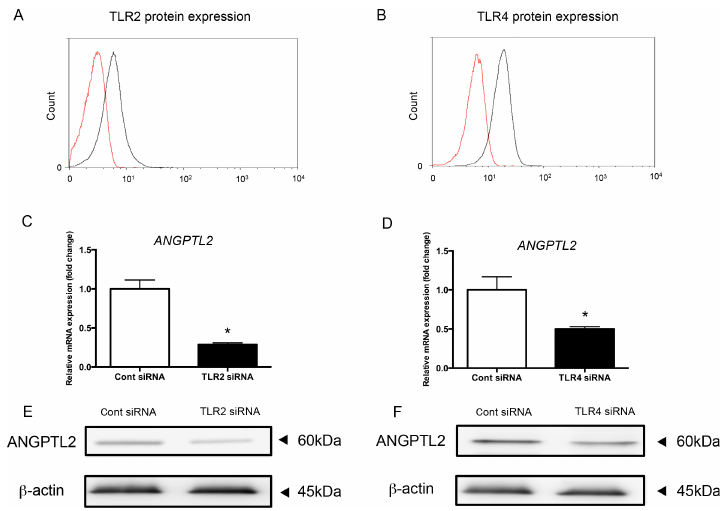
Fig 3. ANGPTL2 expression is suppressed by TLR2 or TLR4 siRNA in Ca9-22 cells. (A, B) TLR2 (A) and TLR4 (B) protein levels Ca9-22cells transfected with TLR2 and TLR4 siRNA (red line), respectively, and control siRNA-transfected cells (black line). (C, D) ANGPTL2 mRNA levels in Ca9-22 cells transfected with TLR2 and TLR4 siRNA after stimulationwith 30 ng/ml P . gingivalis LPS for 24 h. Differencesamonggroups were analyzedwith the Student’s t -test. Data are expressedas means ± SD ( n = 3). * p < 0.05 vs control. (E, F) Western blot analysisof ANGPTL2 protein levels in Ca9-22 cells transfected with TLR2 and TLR4 siRNA after stimulationwith 30 ng/ml P . gingivalis LPS for 24